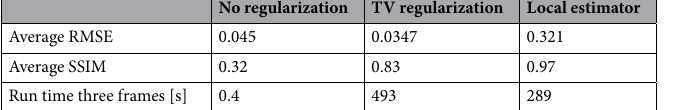
Table 4. Summary of results local estimator